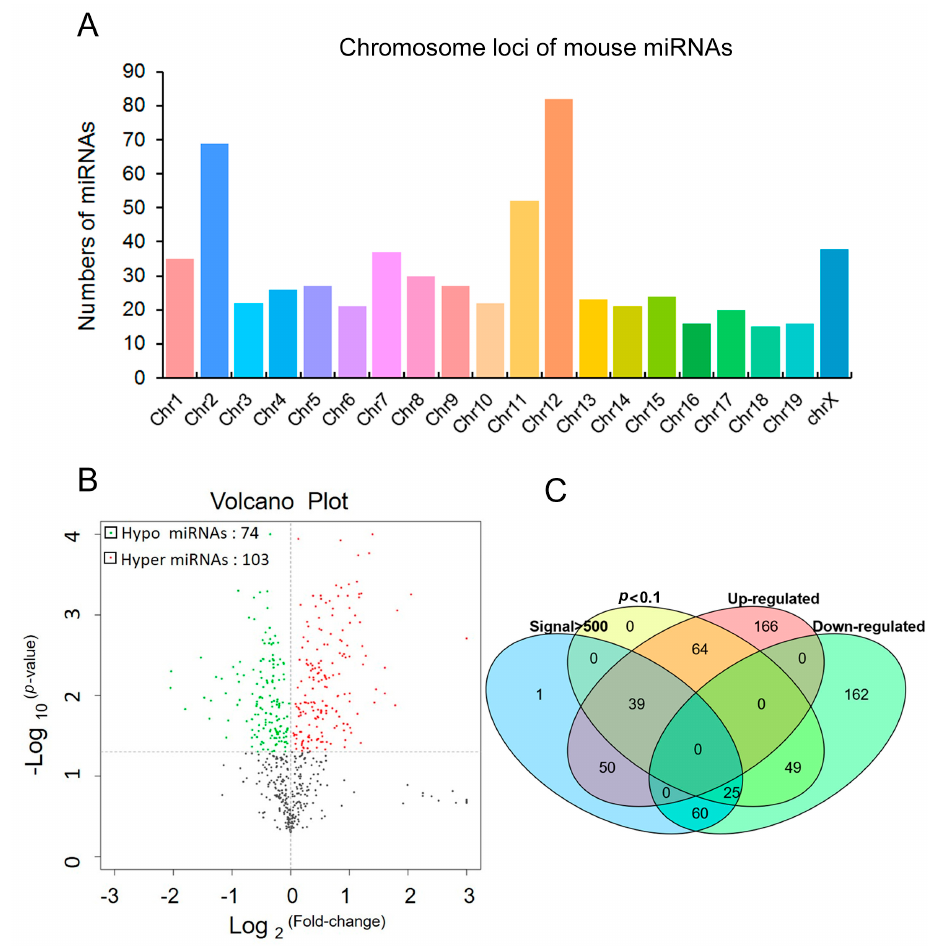
Figure 1. MiRNA expression in hippocampi of antidepressant administration and control mice. ( A ) The numbers of miRNAs in mouse chromosome loci in Affymetrix array analysis; ( B ) Volcano plot of miRNA expression levels in antidepressant administration and control group. Each point represents a miRNA, “red” dot means hyper, “green” dot means hypo expression and “black” dot means none significance (antidepressant vs. control); ( C ) Venn diagram of miRNA array results. The ellipses in different color (blue, yellow, red and green) represent miRNAs in four groups: signal > 500 (175 miRNAs), p < 0.1 (177 miRNAs), up-regulated (319 miRNAs) and down-regulated (296 miRNAs), respectively. The overlapping parts of ellipses represent the intersection of different groups, such as 103 and 74 miRNAs were in up-regulated and down-regulated groups ( p < 0.1), respectively.